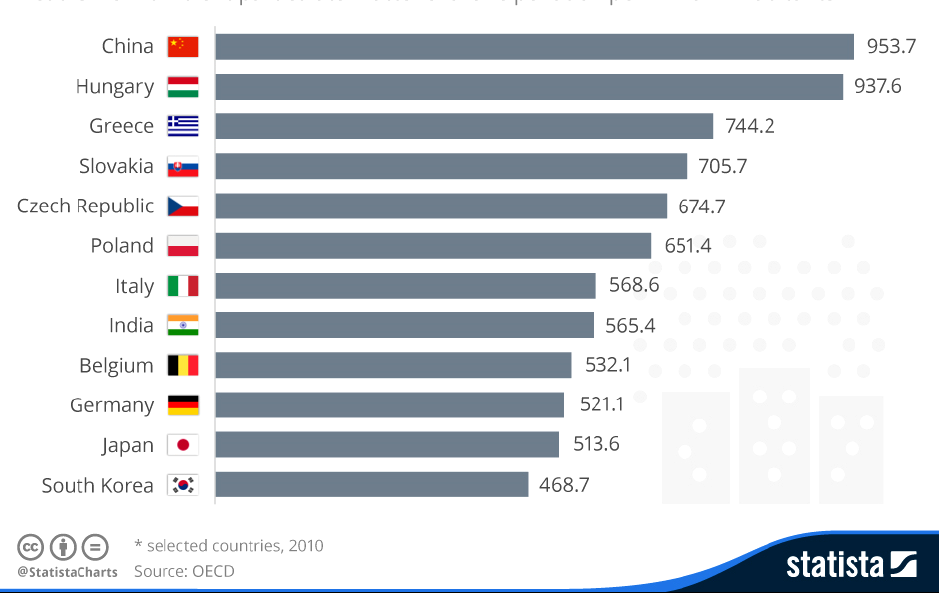
Fig. 10: Death per million inhabitants due to particulate matter and ozone (Statistica, 2016)